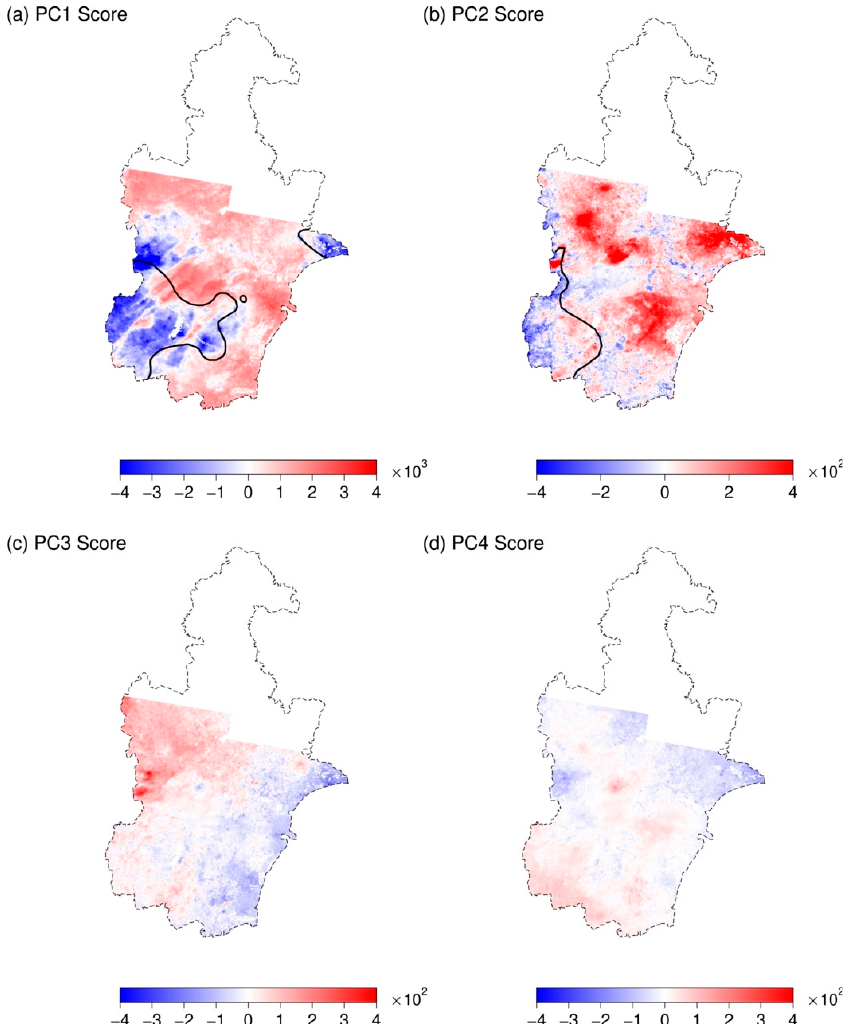
Figure 15. The score maps of the first four PCs. ( a – d ) are score maps for PC1, PC2, PC3, and PC4, respectively. The black contours in ( a ) PC1-score map represent the − 60 m contour of the hydraulic head in Aquifer III as of 2021 (Figure 12f); ( b ) represent the − 40 m contour of the hydraulic head in Aquifer II as of 2021 (Figure